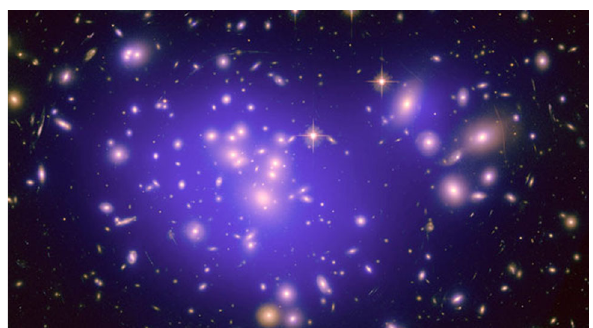
Fig. 1 The image shows combined X-ray/optical of cluster Abell 1689 at z = 0.18. Galaxies in the optical band, colored yellow, are Hubble space telescope observations. The long arcs are due to the gravitational lensing of background galaxies due to the gravitating matter in the cluster. The X-ray emission of the gas (at T 1011 K) is shown in the purple haze. (Credit:X-ray: NASA/CXC/MIT; Optical: